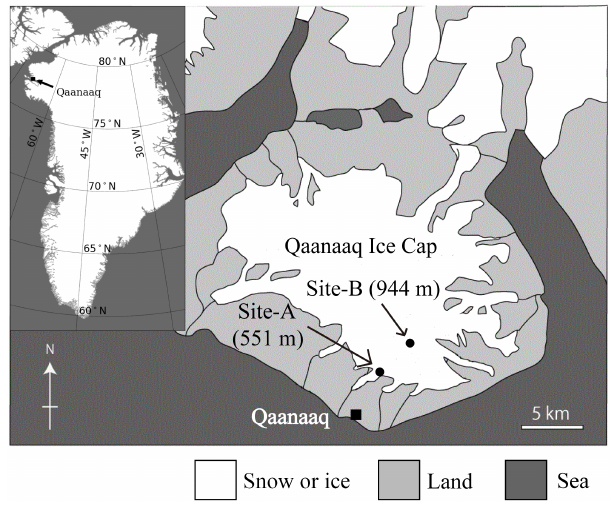
Figure 1. A map of the Qaanaaq ice cap in north-western Green- land, showing the location of sampling sites on the